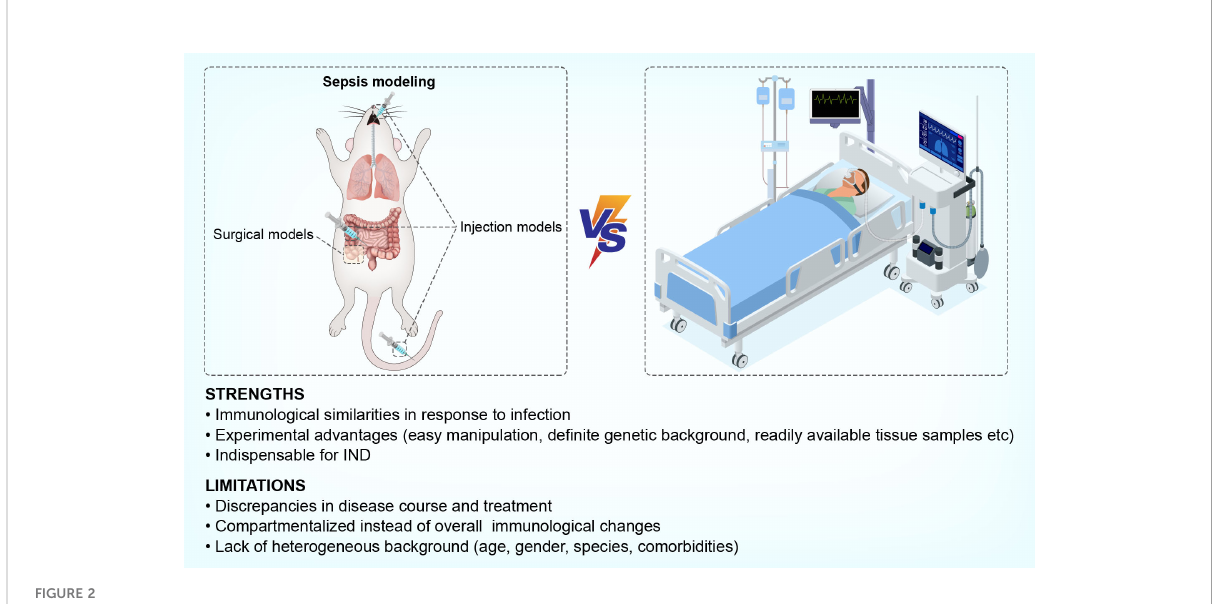
FIGURE 2 Strengths and limitations of using murine models to mimic sepsis-induced immunosuppression in